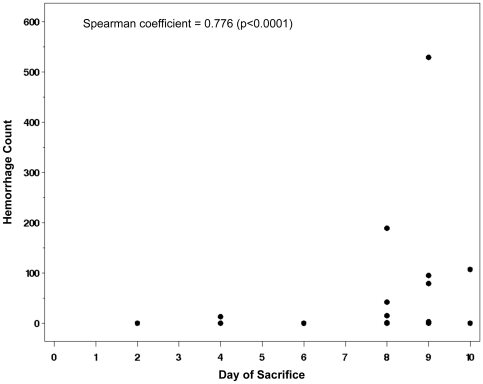
Hemorrhages and day of sacrifice.Intracerebral hemorrhage tally in experimental mice versus day at which subject was sacrificed, demonstrating a positive correlation. Spearman Correlation = 0.776, p<0.0001.